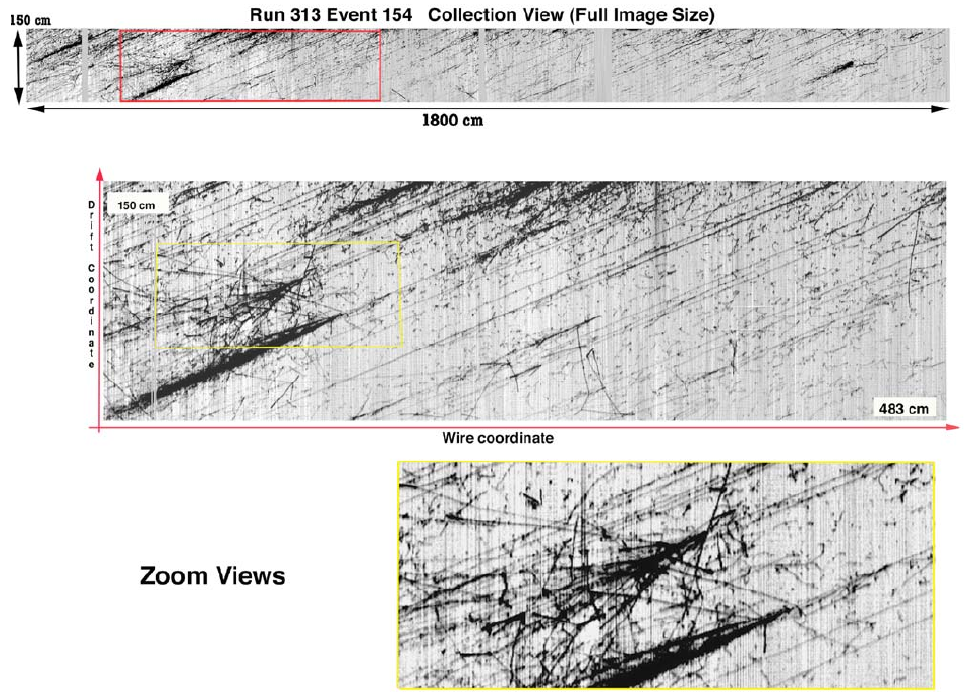
Figure 7. Example of an extensive air shower event collected by ICARUS-T600 in its surface run in Pavia, as seen in Collection